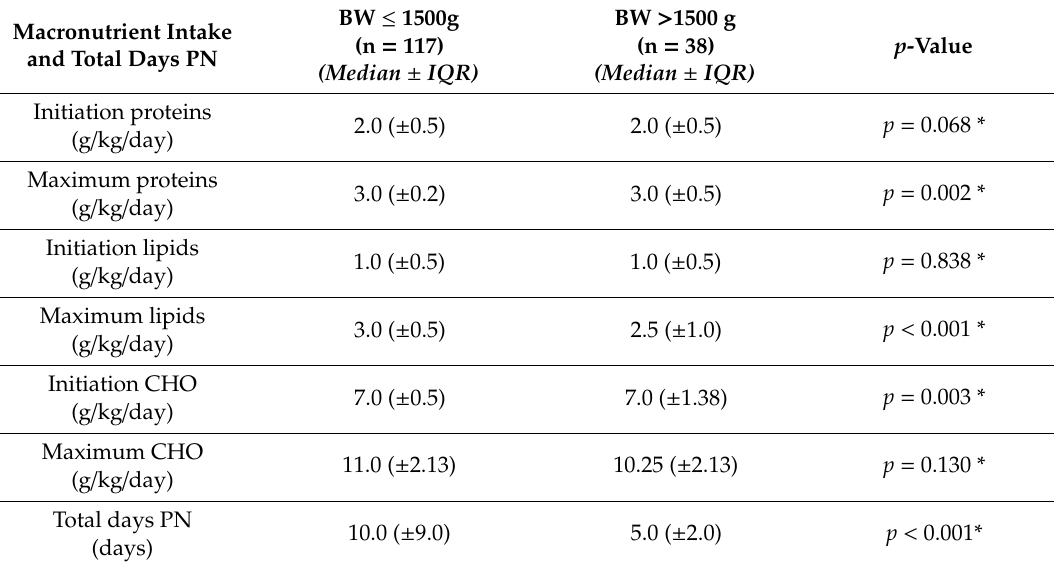
Table 5. Distribution of prescribed macronutrient intake according to birth